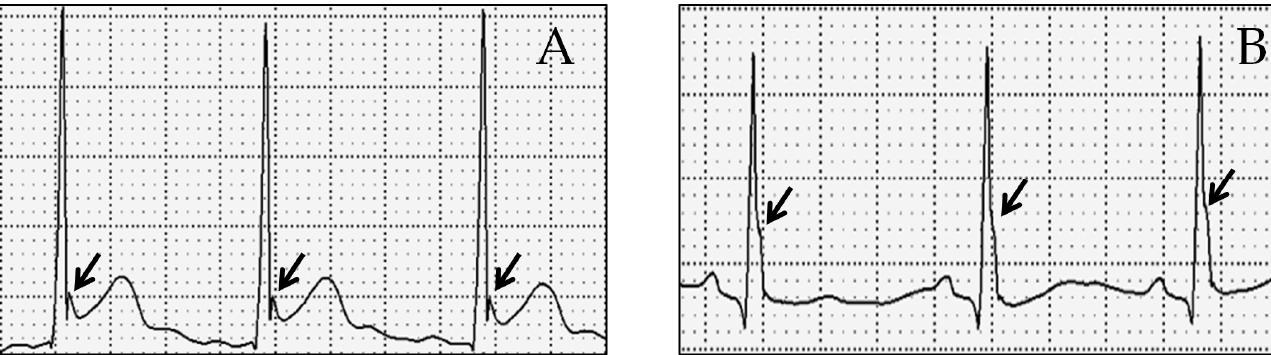
Figure 1. The appearance of J wave as notching at the end of the QRS complex (panel A , arrows), or slur on the descending limb of the positive R wave (panel B , arrows).